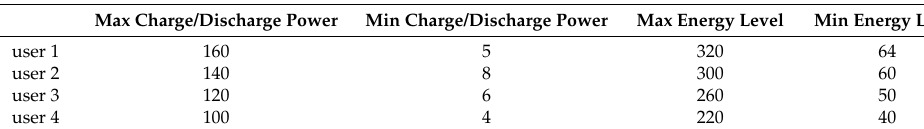
Table 5. Parameters of ESS.